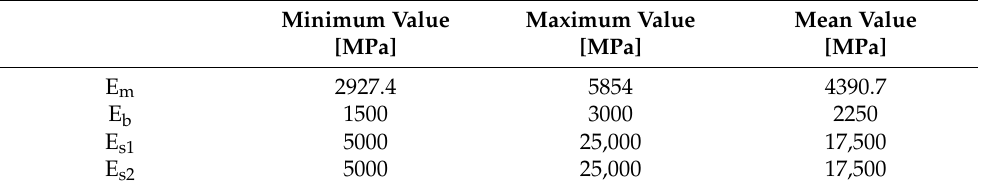
Table 3. Ranges of values considered for the sensitivity